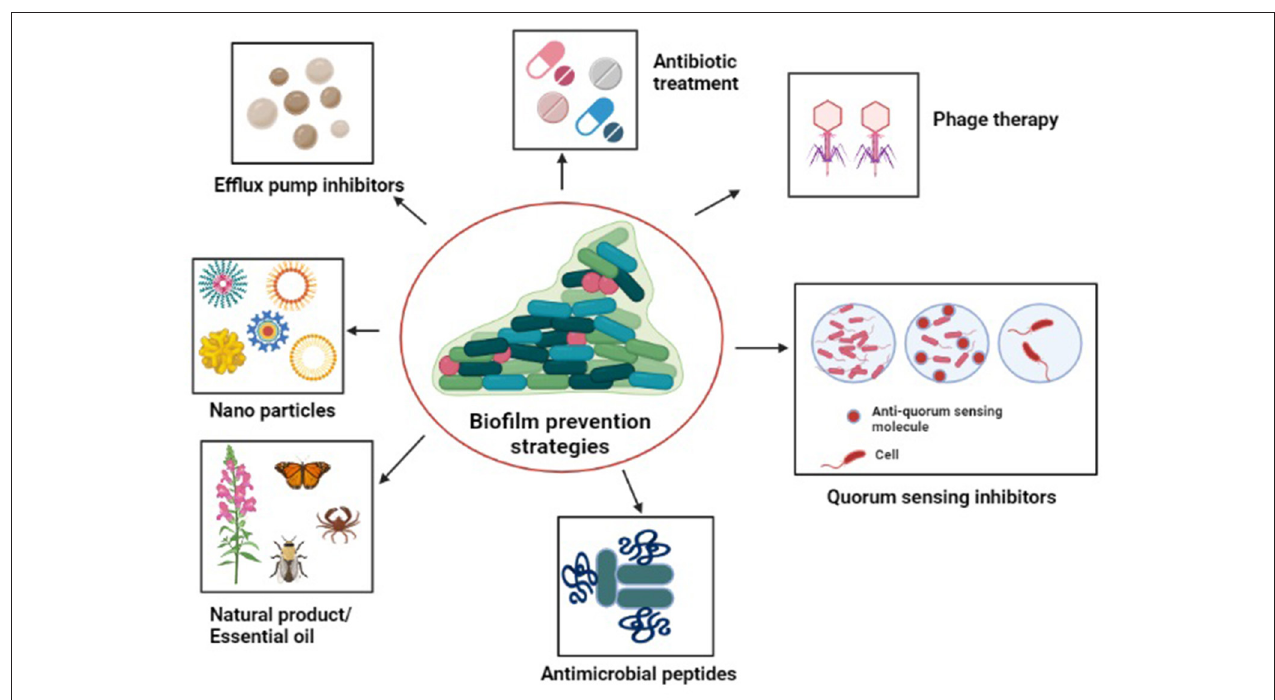
FIGURE 5 | Diagrammatic representation of the strategies to tackle antibiotic-resistant biofilm communities: antibiotic treatment, quorum sensing inhibitors, natural products/essential oils, antimicrobials peptides, efflux pump inhibitors, nanoparticles, and phage therapy.